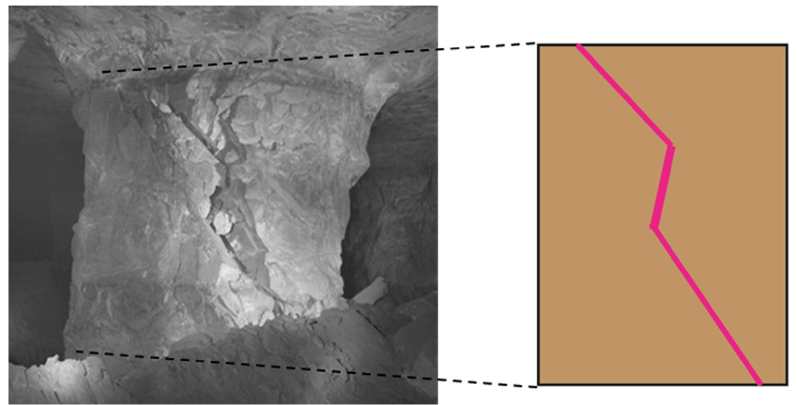
Figure 1. Shear failure of a rock pillar [13].